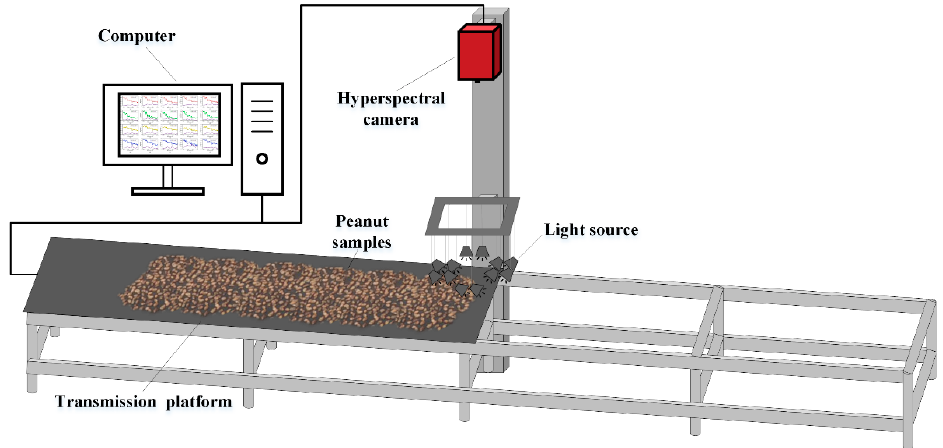
Figure 1. Hyperspectral image acquisition system.